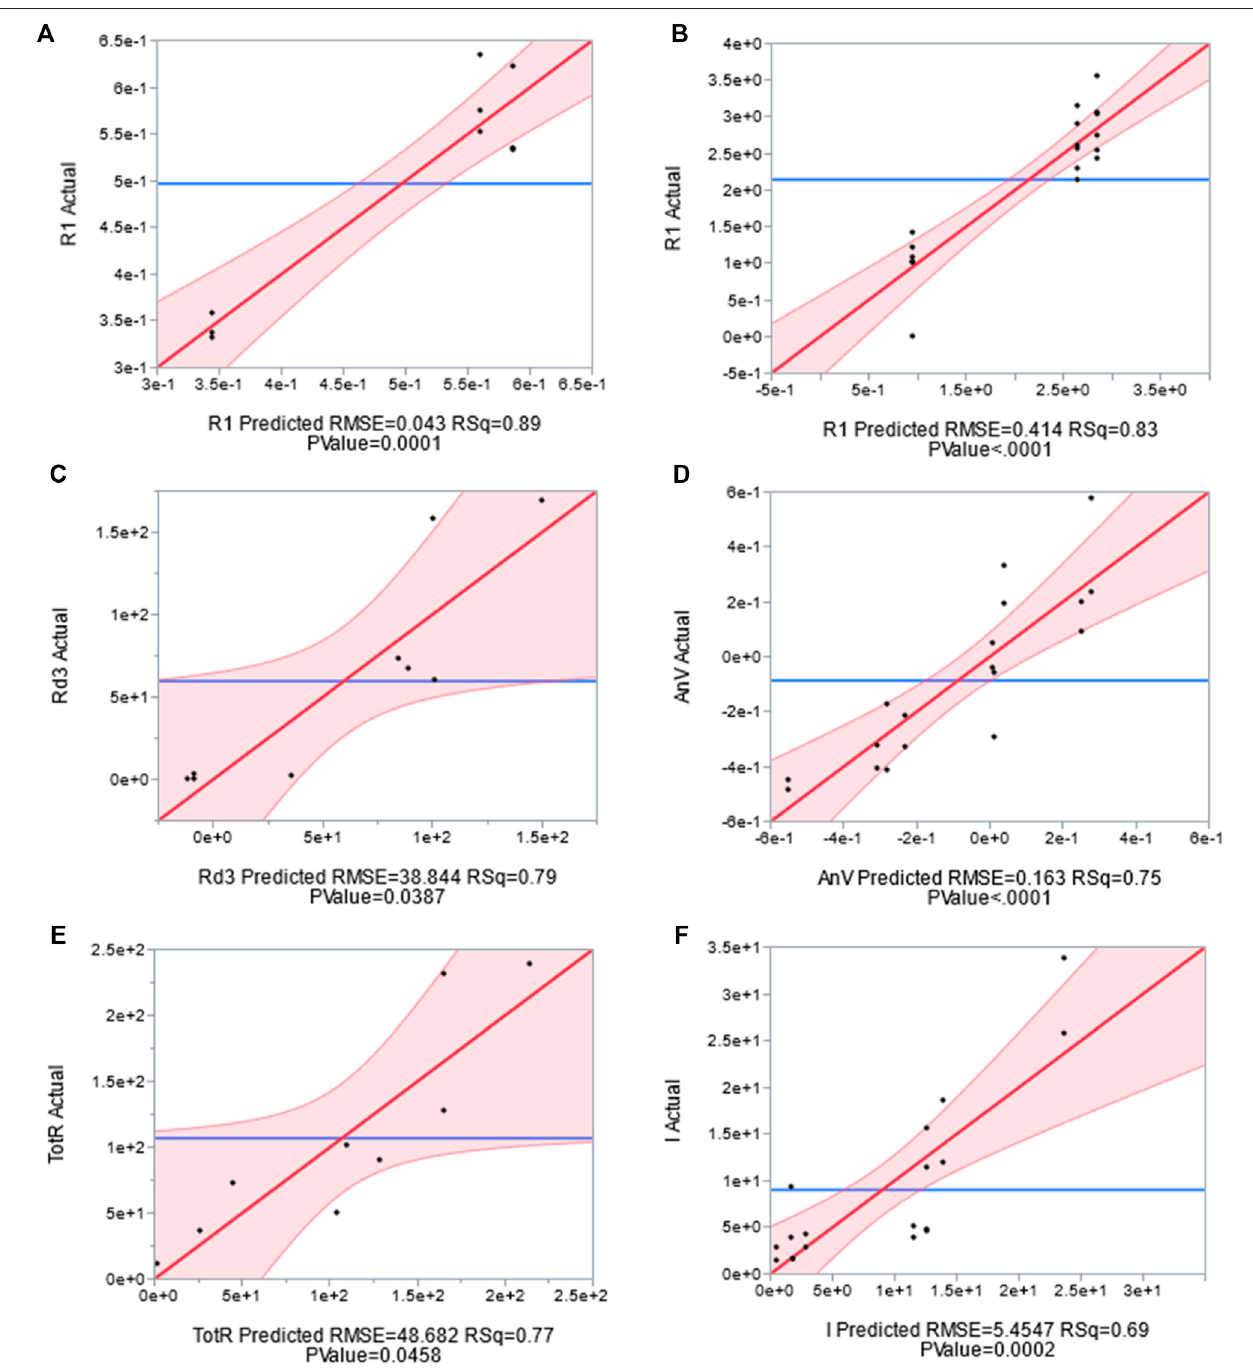
FIGURE4| Actualvs. Predictedplotforcorrelations generatedviamultivariate analysisfor (A) R 1 Anode, (B) R 1 Cathode, (C) Rd 3 Anode, (D) AnV:AnodeVoltage, (E) TotR: Total Impedance, and (F) IActual: Whole Cell Current. The experimentally determined values for the response variables are plotted on the y axis while the predicted responses as a function of buffer, fl ow rate, and applied potential are plotted on the x axis. The shaded region represents 95% con fi dence interval, and the quality of prediction can be assessed by evaluating the distance of each point from the solid red line. RMSE: Room mean squared error, RSq: square of the correlation coef fi